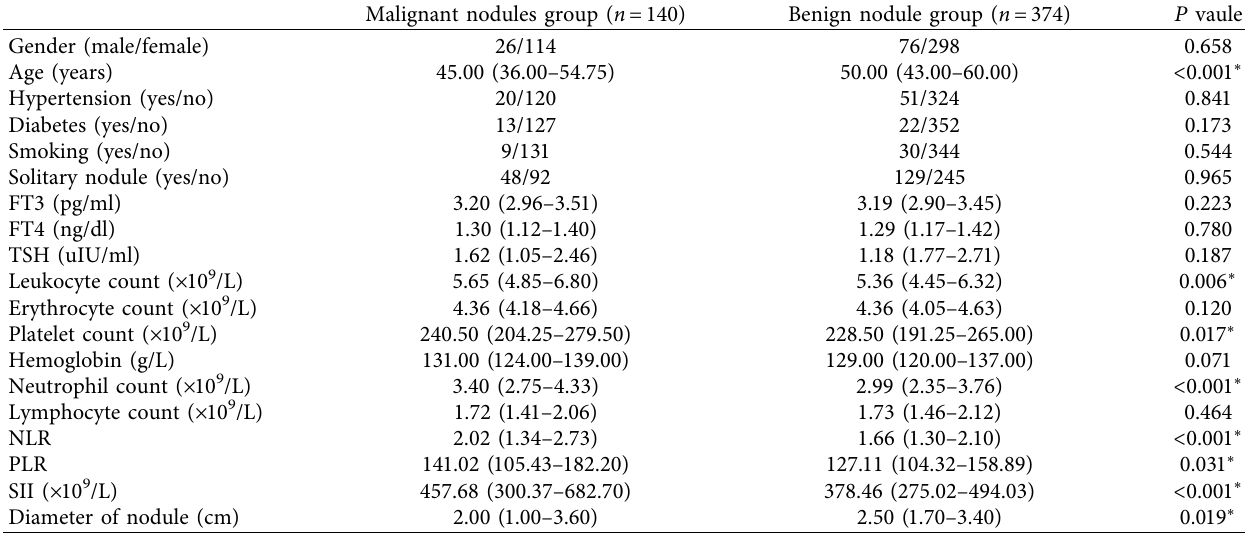
Table 1: Clinical characteristics of benign and malignant thyroid